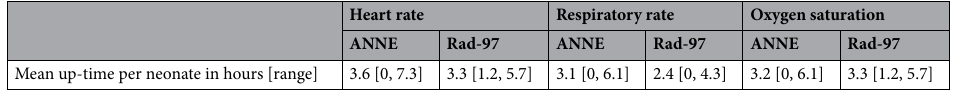
Table 2. Mean up-time per